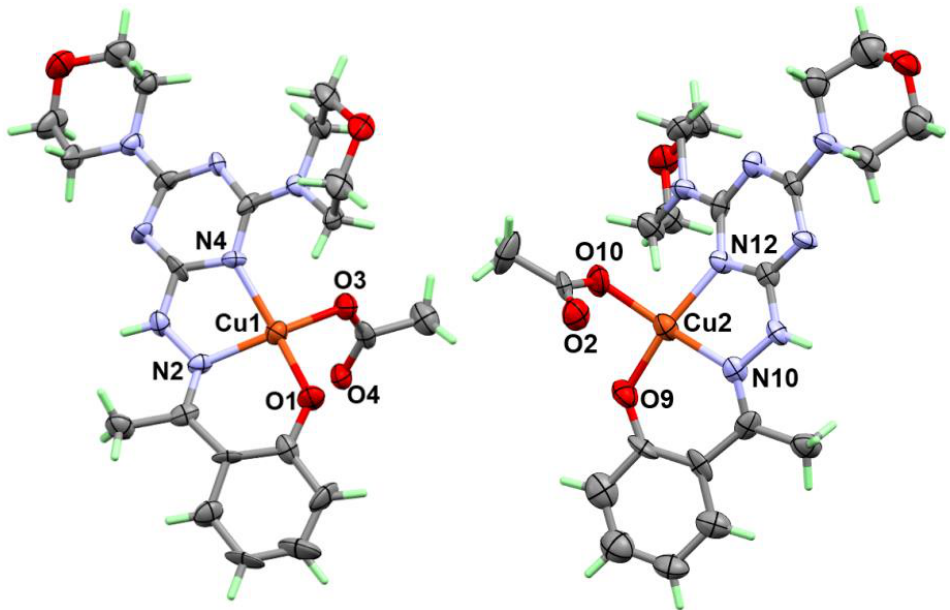
Figure 6. Structure and atom numbering of the coordination sphere of complex 2 .